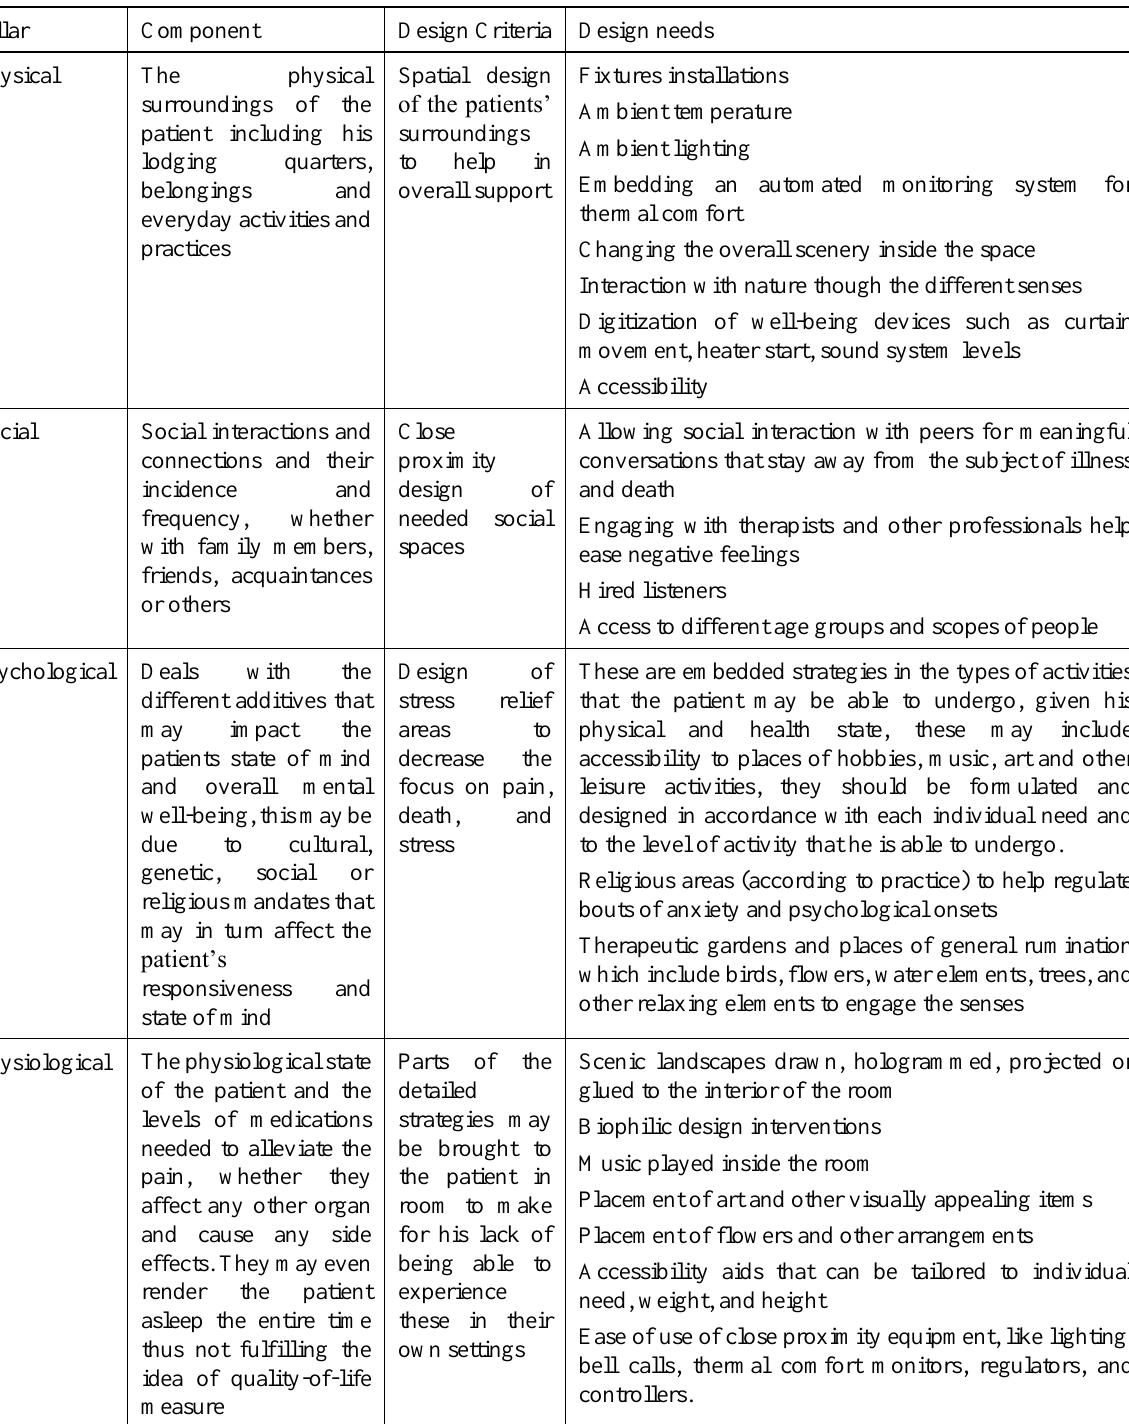
Table 1: Aspects of personalization of spatial design based on user-centred design and tailored to each individual need